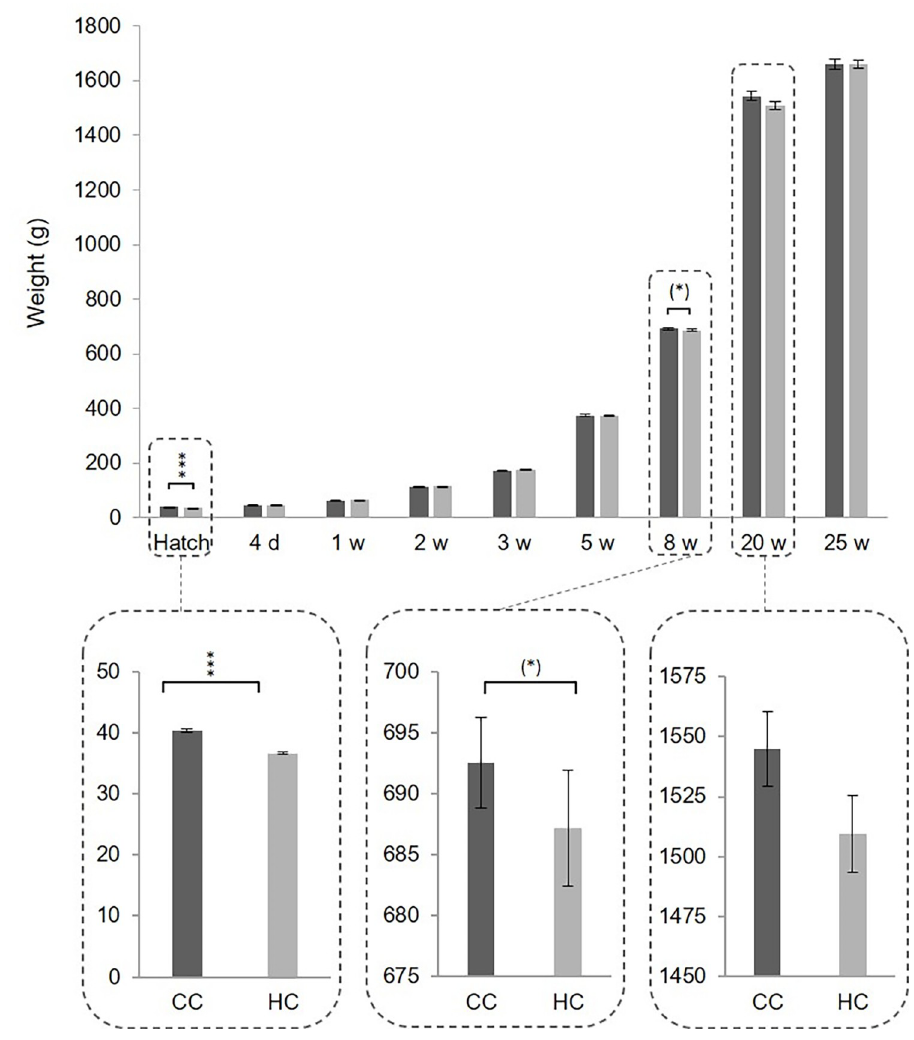
Fig 1. Weight at different ages in chicks from a commercial hatchery (HC) and control chicks (CC), ( � )p < 0.1, ��� p < 0.001. At 20w of age, p =